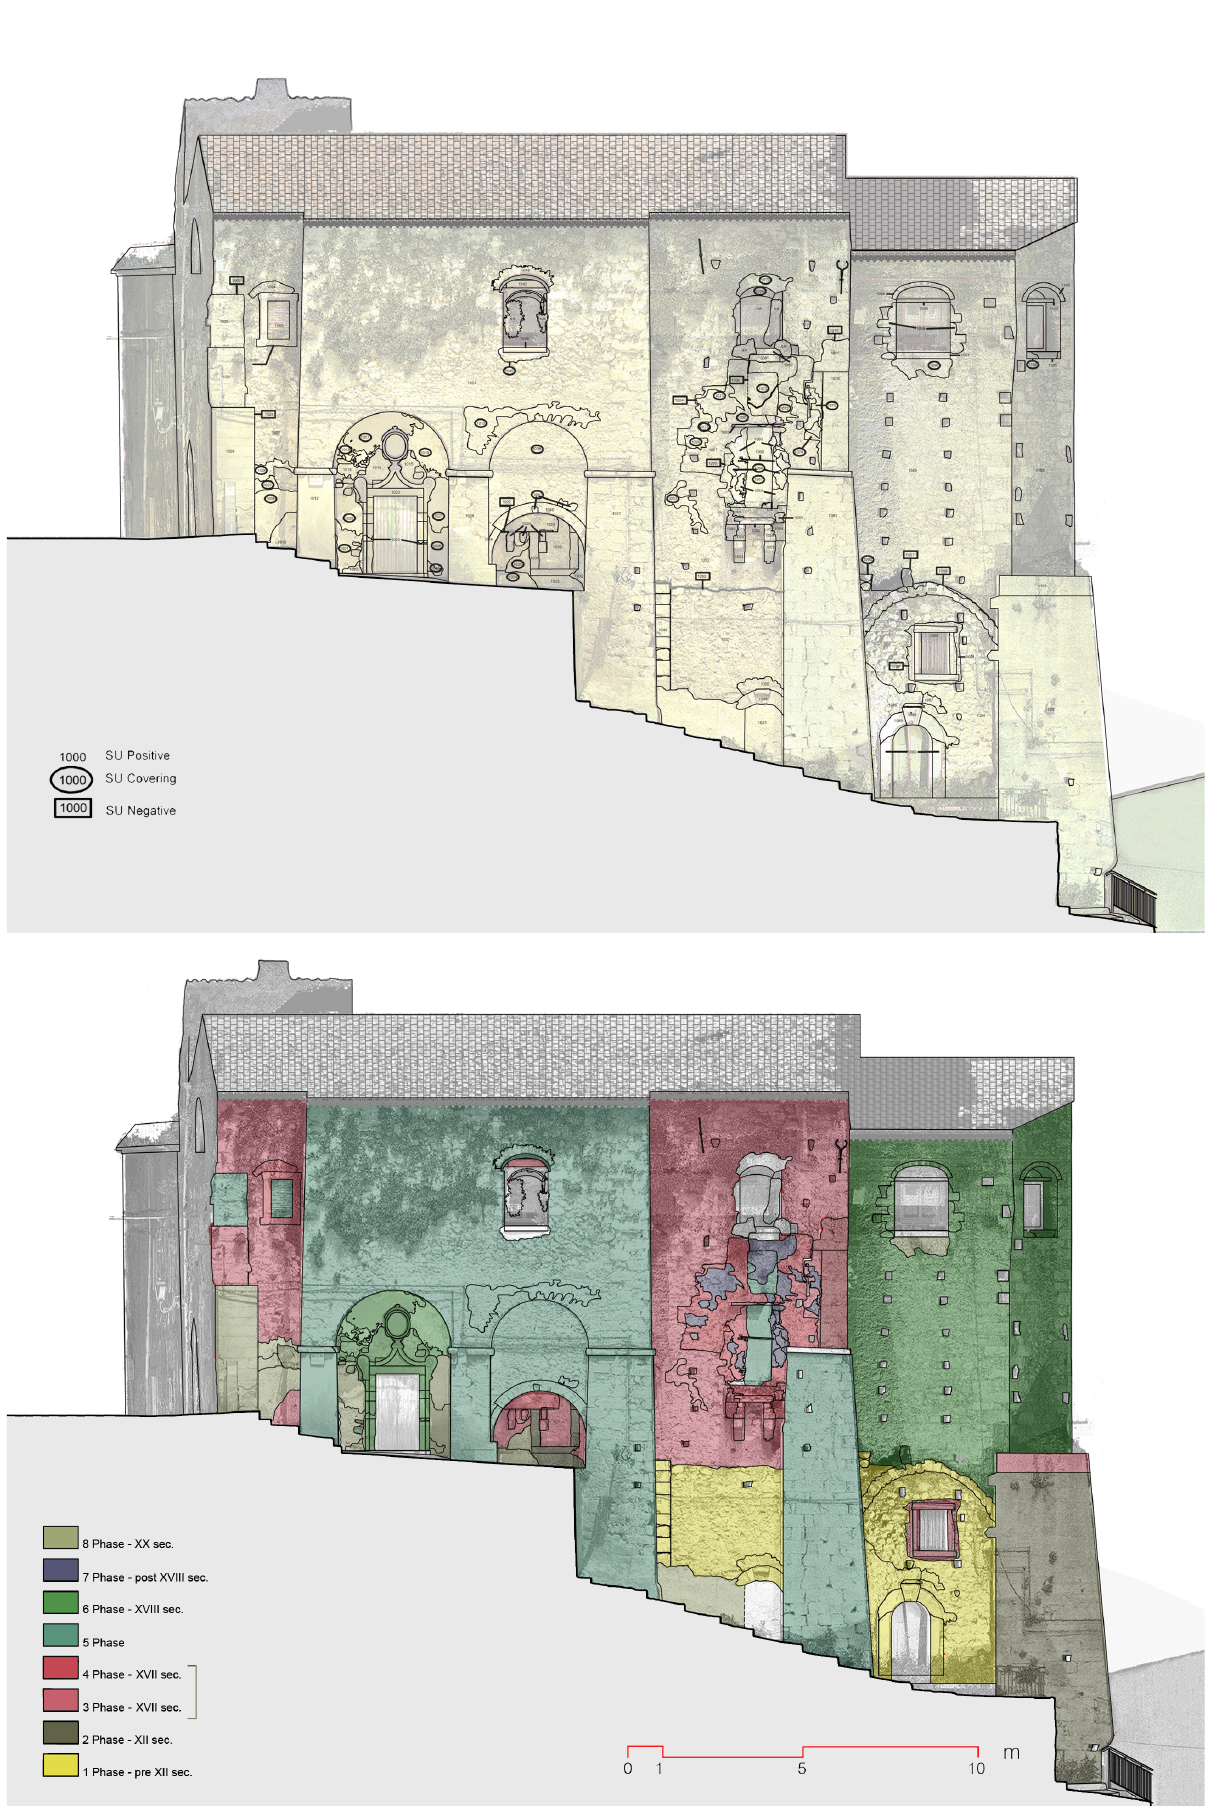
Fig. 6: Stratigraphic reading and representation of the temporal phases on the south-western front of the point cloud